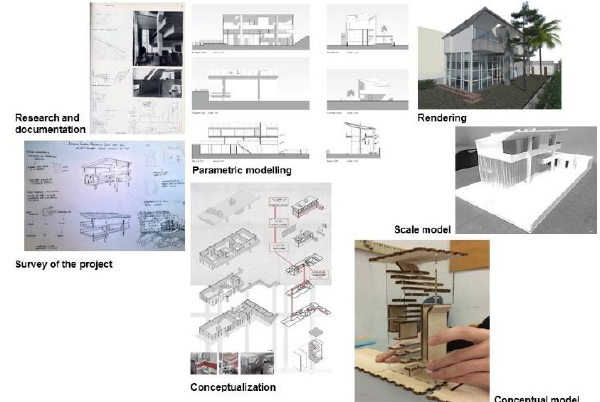
Figure 1. Schematic representation of the main steps of the methodological process: Research and documentation, Survey of the project, Parametric modelling, Rendering, Scale model, Conceptualization process, Conceptual